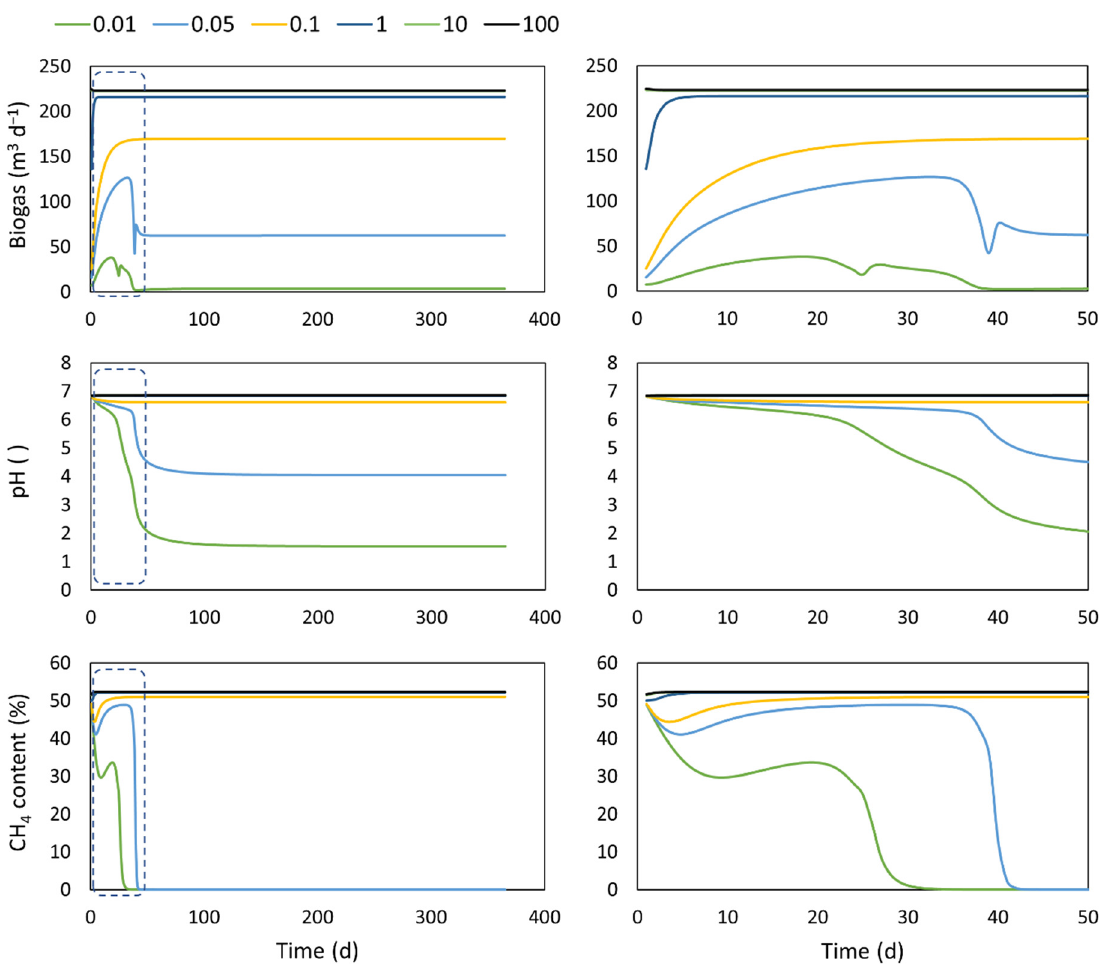
Figure 3. Performance of a digester under different extra- intra- cellular transport kinetics. Left : results of 365 days of operation. Right : zoom in on 50 days of operation.